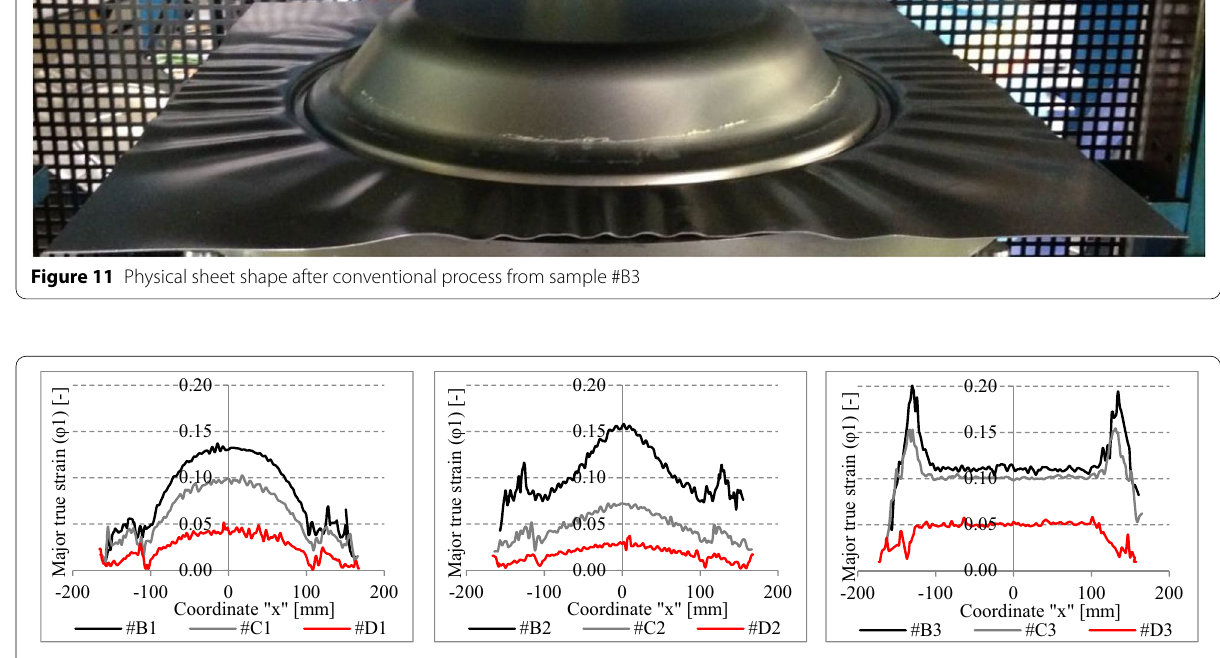
Figure 12 Major experimental true strains found along the “ x ”